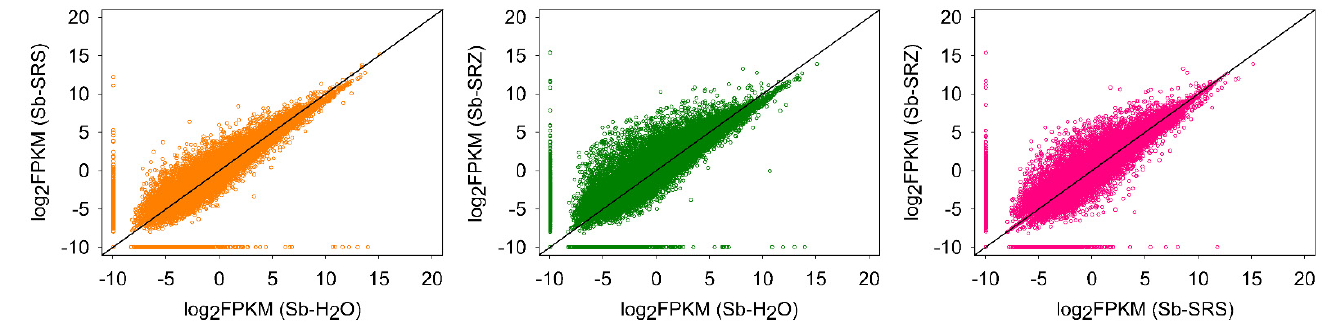
Figure 1. Comparison of FPKM of all sorghum genes at 3 days after inoculation. FPKM (fragments per kilobase of exon model per million mapped reads) values for transcripts detected in the comparison of Sb-SRS vs. Sb-H 2 O ( left ), Sb-SRZ vs. Sb-H 2 O ( middle ) or Sb-SRS vs. Sb-SRZ ( right ). A constant of 0.00001 was added to each FPKM to avoid zero scores in log calculations.